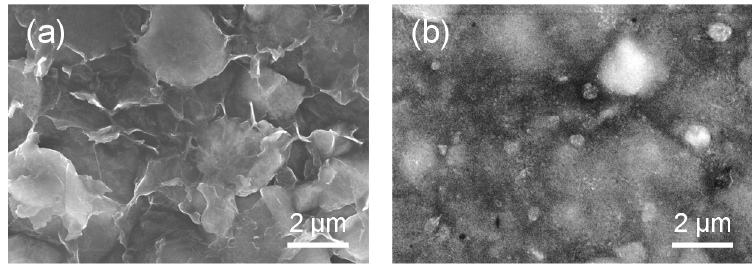
Figure 5. Electrochemical performances of the pristine STN and the rGO-SWNT-STN electrodes. ( a ) Initial cycle voltage profiles at a rate of 0.1 C , ( b ) Cycle retentions at a rate of 1 C , ( c ) Coulombic efficiency at a rate of 1 C , ( d ) Rate capabilities at various C rates.